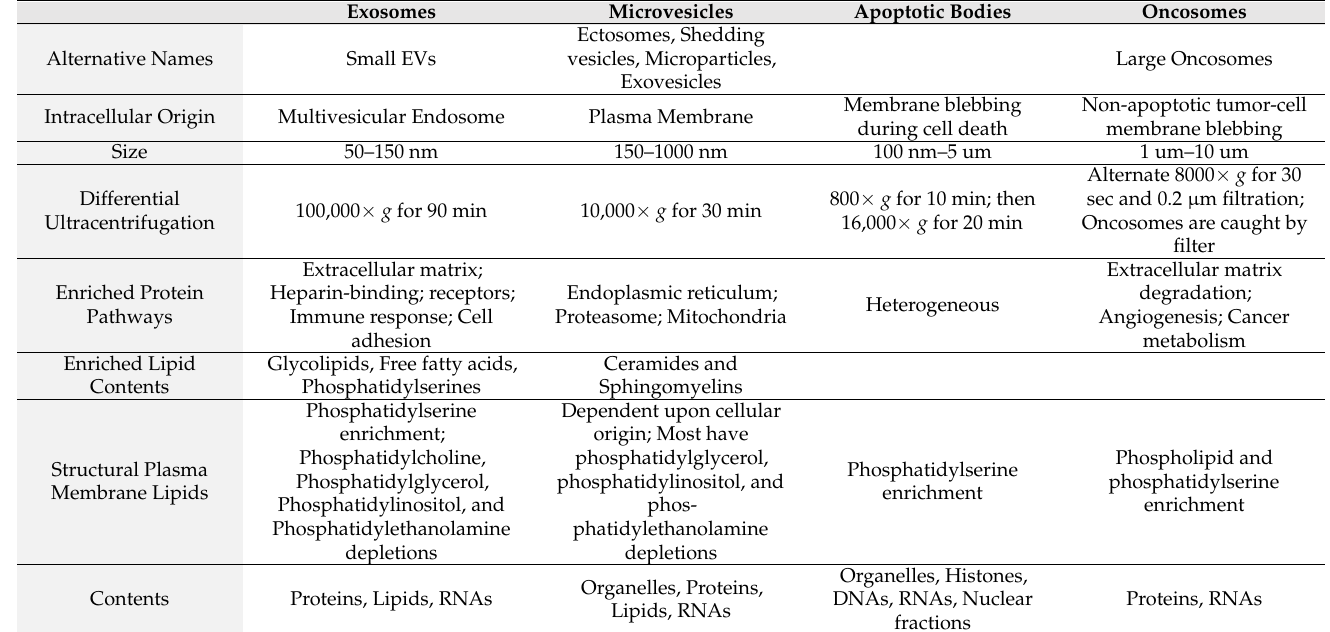
Table 1. Subtypes and Properties of Extracellular